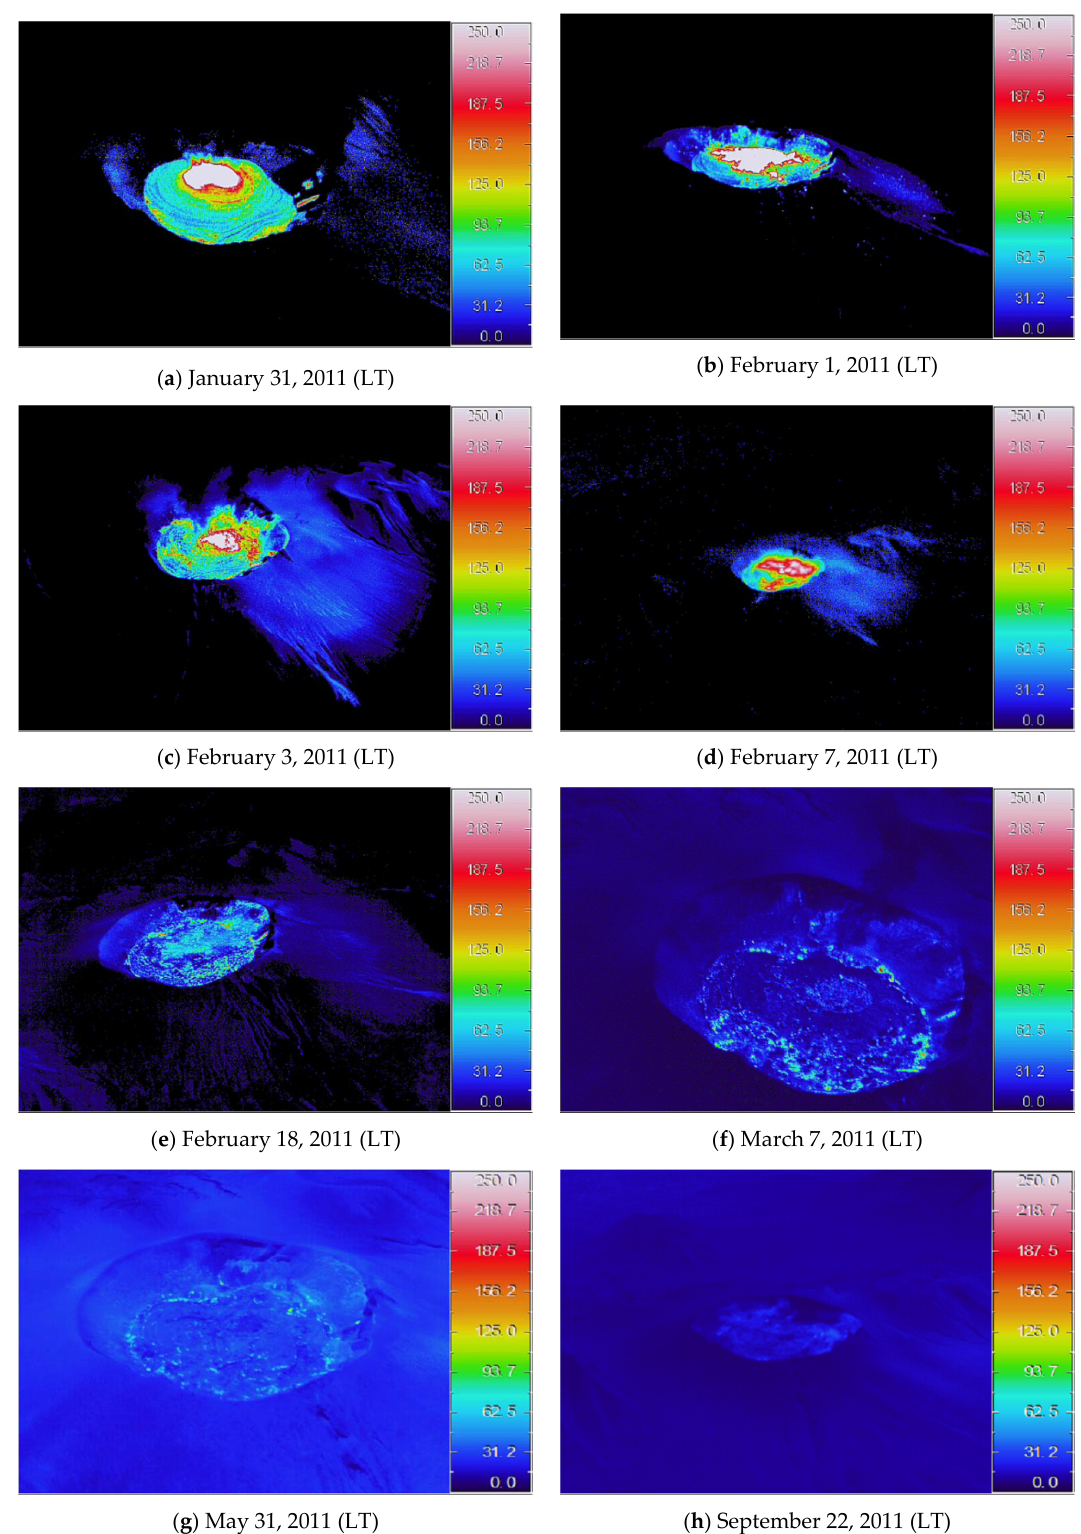
Figure A2. Aerial thermal infrared images of the summit crater of Shinmoedake (after JMA report [29]). ( a ) 31 January, ( b ) 1 February ( c ) 2 February, ( d ) 3 February, ( e ) 18 February ( f ) 7 March, ( g ) 31 May, ( h ) 22 September. The central part of the discharged lava was very hot at first, but the surface temperature of the lava gradually decreased.